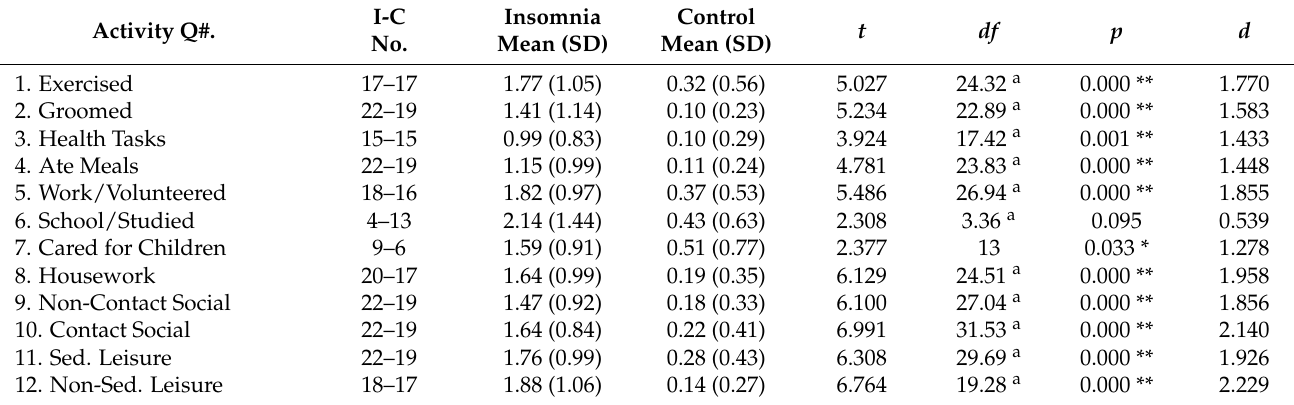
Table 2. Negative sleep impact scores for all 12 SIAD activities between insomnia and control groups. Activity Q#.